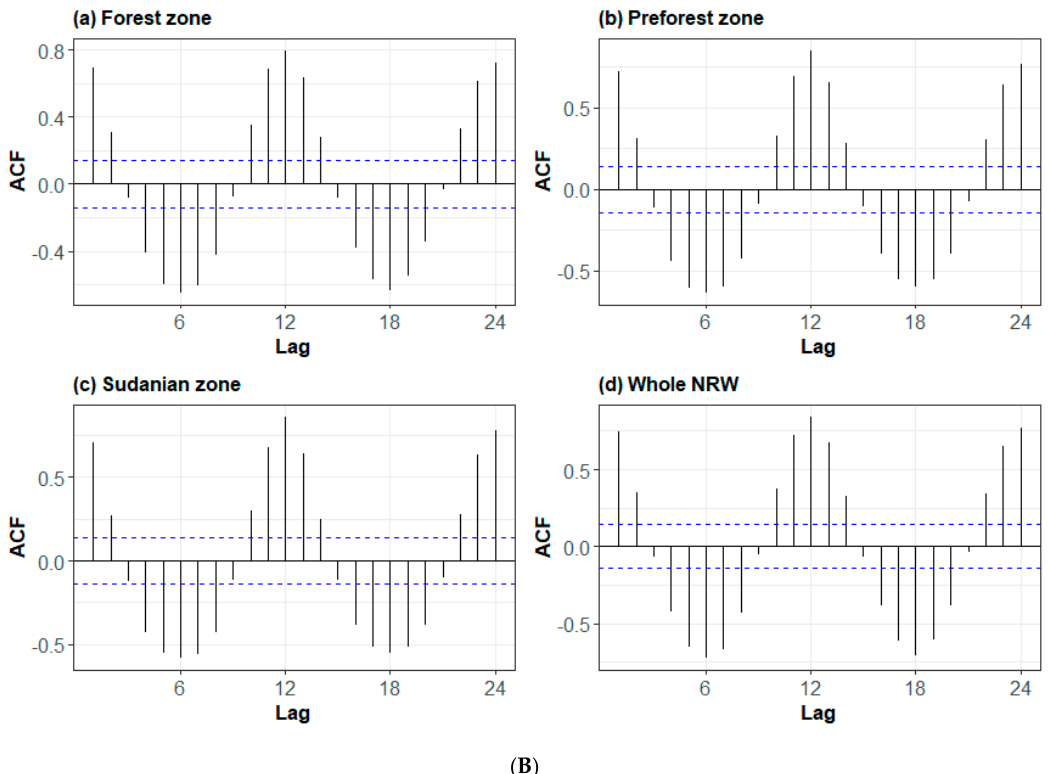
Figure 3. Autocorrelation functions of (A) the number of wildfires and (B) burnt areas. The two blue dashed lines across the plot indicate the point of statistical significance. Values between these lines and zero are not statistically significant, while those above and below the lines